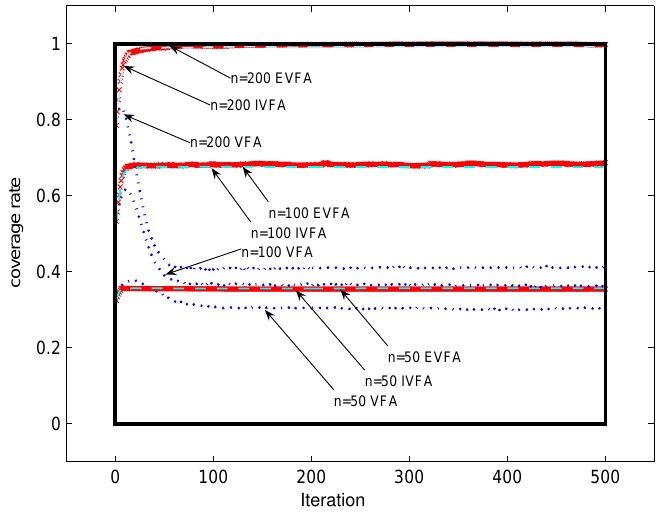
Fig.5 (cid:3) C r (cid:3) under (cid:3) VFA, (cid:3) IVFA, (cid:3) EVFA (cid:3) with (cid:3) different (cid:3) n (cid:3)